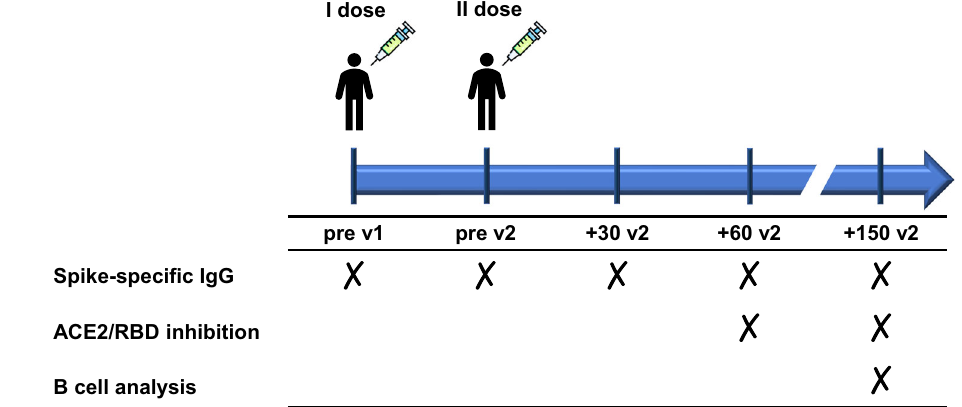
Fig. 1 Schematic representation of the study design. PLWHIV (84 subjects) and healthy controls (HCs, 79 subjects) vaccinated with two doses of a SARS-CoV-2 mRNA vaccine (BNT162b2 P fi zer-BioNTech or mRNA-1273 Moderna) 3 – 4 weeks apart, respectively, were enrolled in the study. Blood samples were collected at pre v1 (day 0, baseline), pre v2, + 30 v2 (1 month post second dose), + 60 v2 (2 months post second dose), and + 150 v2 (5 months post second dose). Plasma samples were tested for spike-speci fi c IgG and ACE2/RBD binding inhibition while PBMCs were analyzed for spike-speci fi c B-cell response.